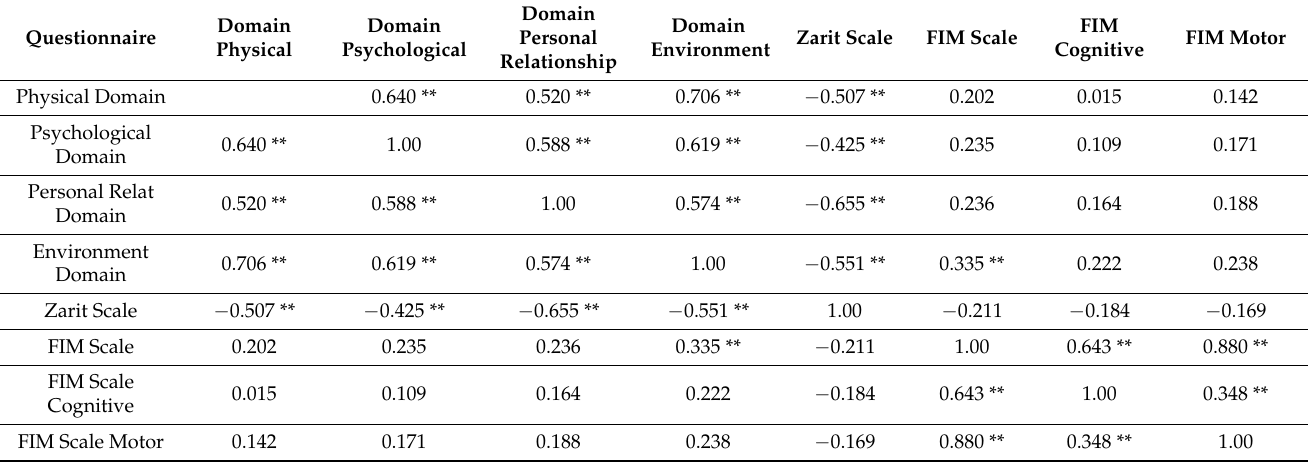
Table 4. Spearman correlation coefficients between WHOQOL-bref domains, Zarit scale and FIM